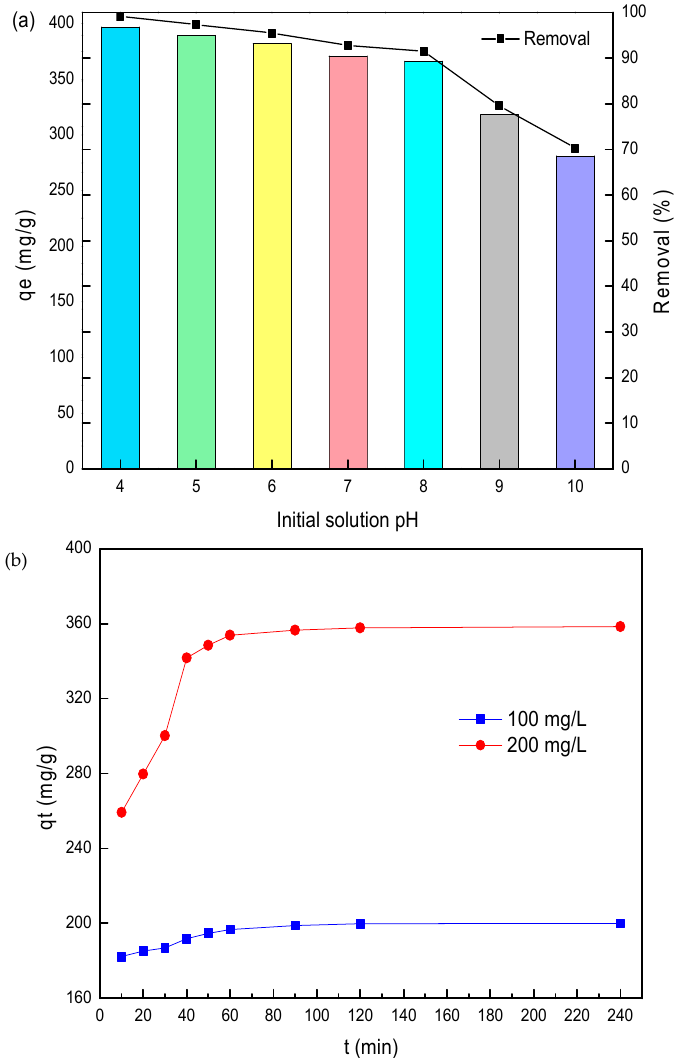
Figure 5. ( a ) Effect of initial solution pH on SL adsorption using 2.8%CB-LDH and ( b ) effect of contact time on SL adsorption using 2.8%CB-LDH for initial SL concentrations of 100 and 200 mg/L.